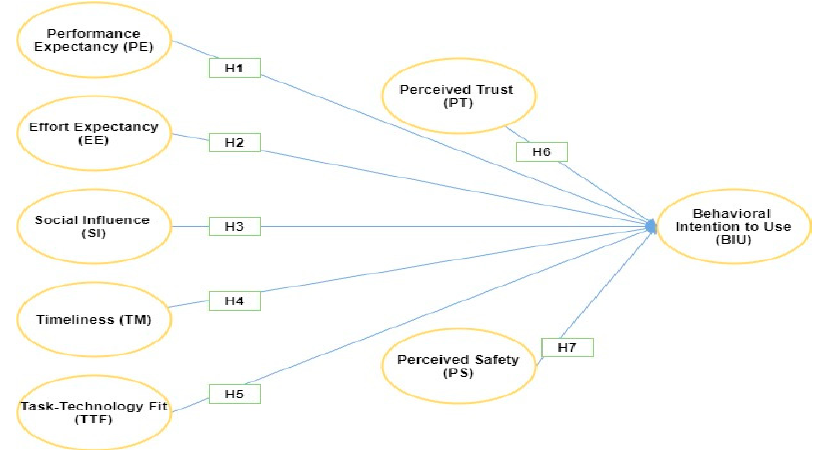
Figure 1. Proposed research model.